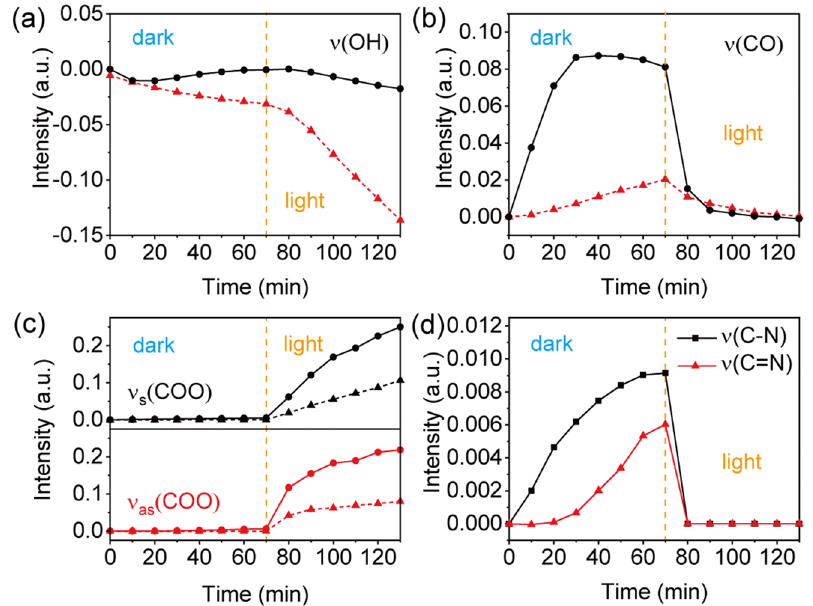
Figure 6. Peak intensities of surface species for formaldehyde adsorption and oxidation under dark (0~70 min) and light (70~130 min) as a function of the reaction time. ( a ) ‐ OH species; ( b ) C ‐ O species; ( c ) COO species; ( d ) C ‐ N/C=N species. The solid line is for C 60 ‐ EDA/TiO 2 and the dashed line represents TiO 2 .